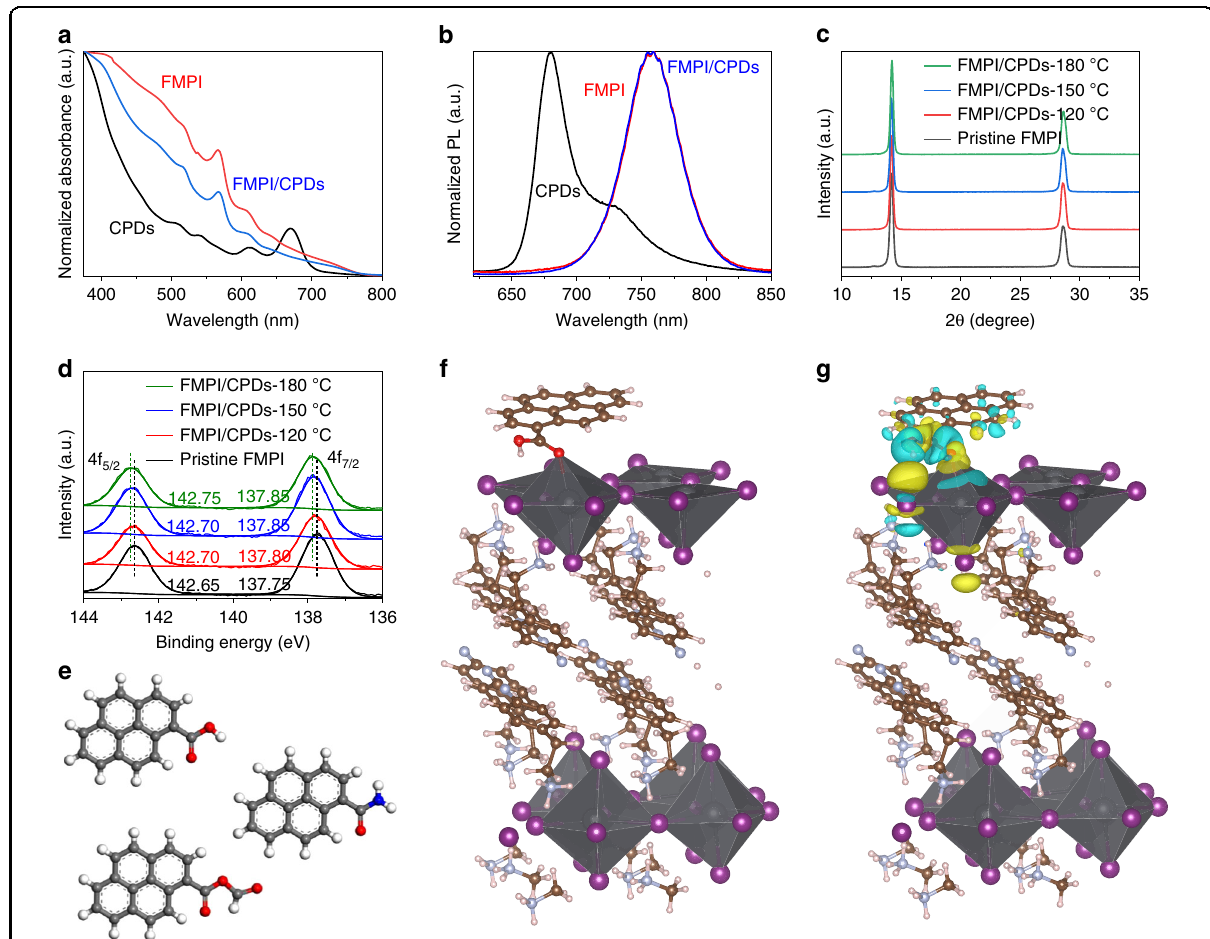
Fig. 2 Interactions between FMPI and CPDs. a The absorbance and ( b ) photoluminescence spectrum of CPDs-120 °C, pristine FMPI, and FMPI/ CPDs-120 °C. c XRD and ( d ) XPS pattern of pristine FMPI and FMPI/CPDs thin fi lms. e Built brief structure of CPDs with carboxylic acids, amides, and anhydrides groups, respectively. f The optimized structure and ( g ) differential charge analyses of CPDs with carboxylic acid group coordinate with unbonded Pb